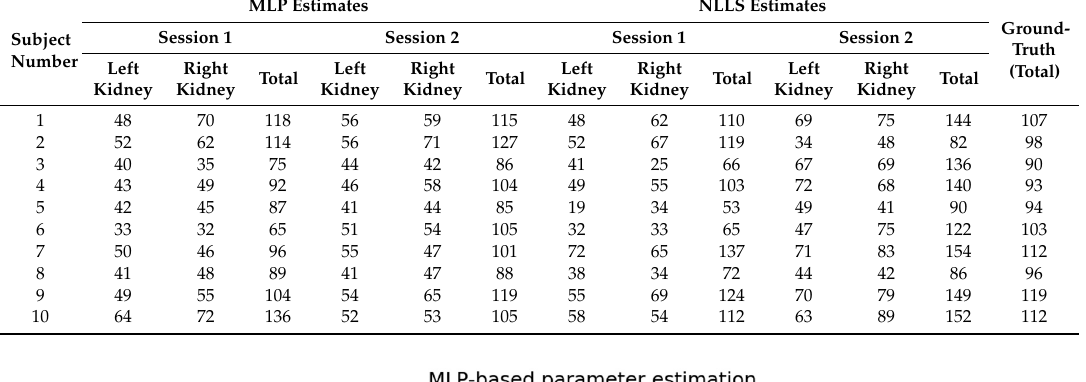
Figure 10. Determination coefficients for two-compartment filtration model (2CFM) model parameters obtained for various network configurations (test set).